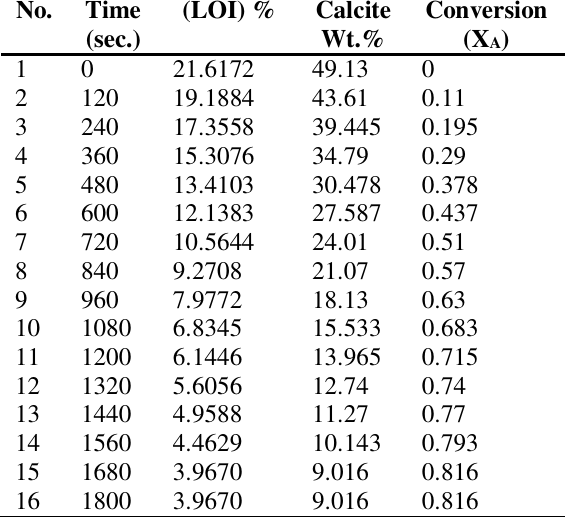
LOI data of phosphate ore leaching using